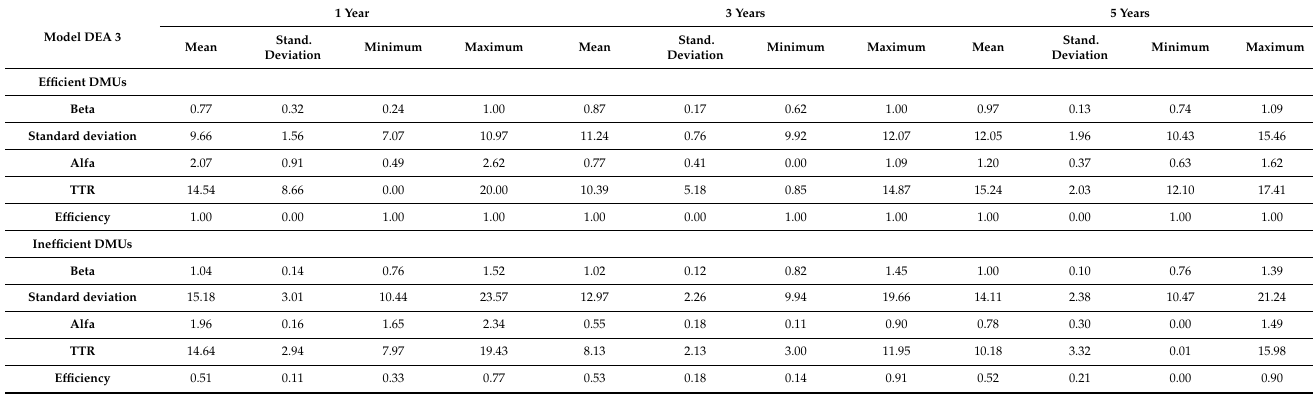
Table A10. Descriptive statistics of efficient and inefficient DMUs in model M3.